Question: Give a one-sentence summary of this figure.
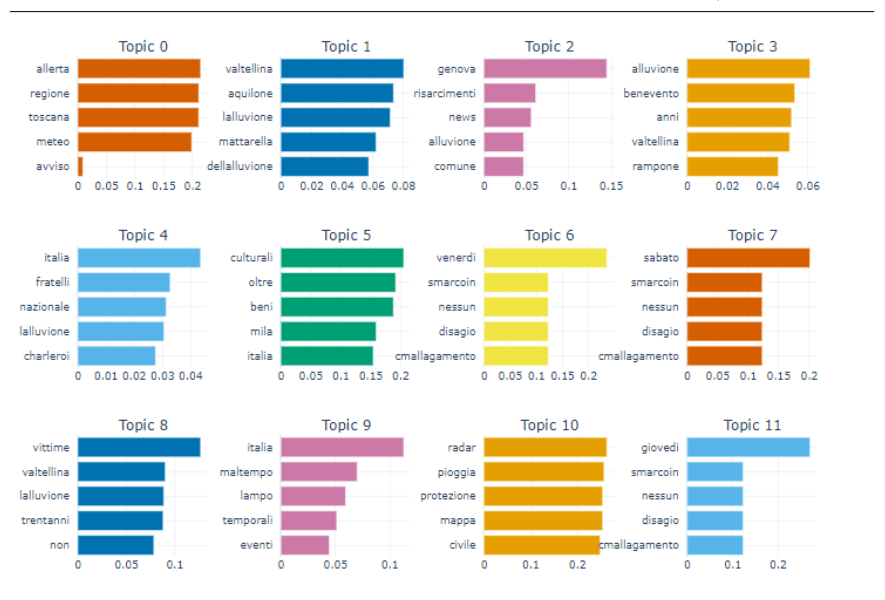
Answer: Word scores of the topics extracted from the tweets relevant referring to frequently mentioned location.